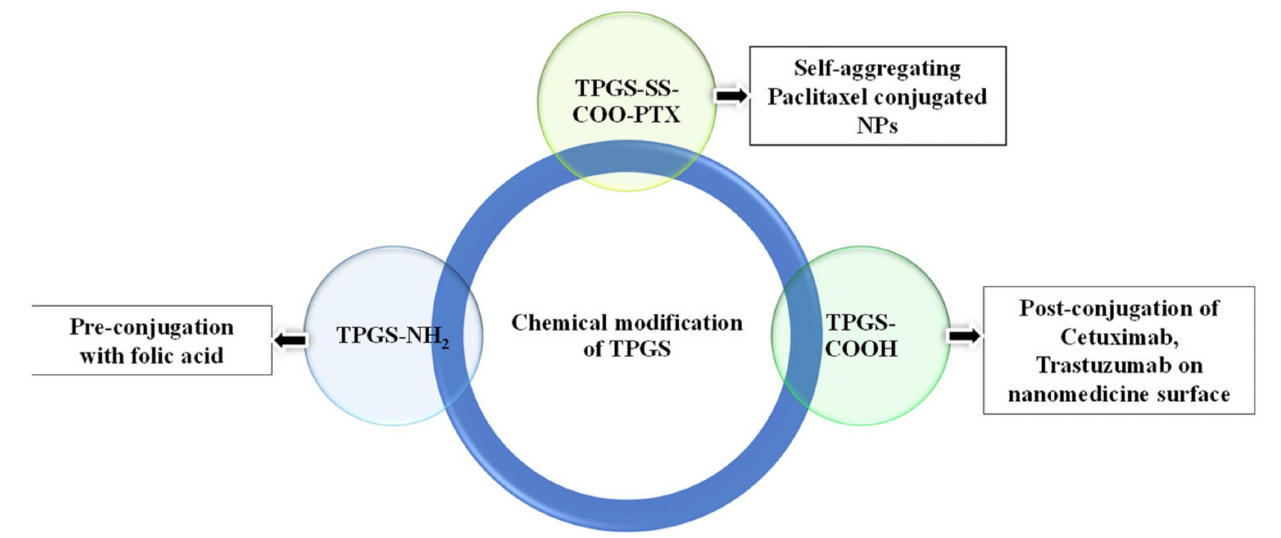
Figure 2. Various examples of chemically modified TPGS in cancer drug-delivery